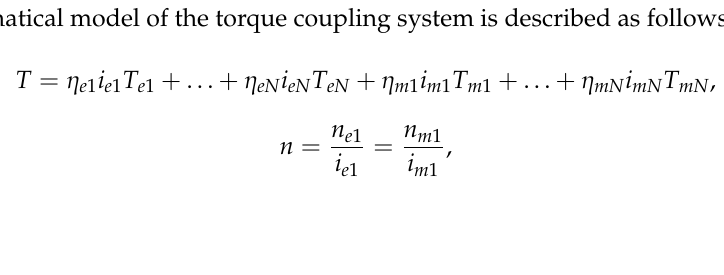
Figure 6. Schematic diagram of torque coupling